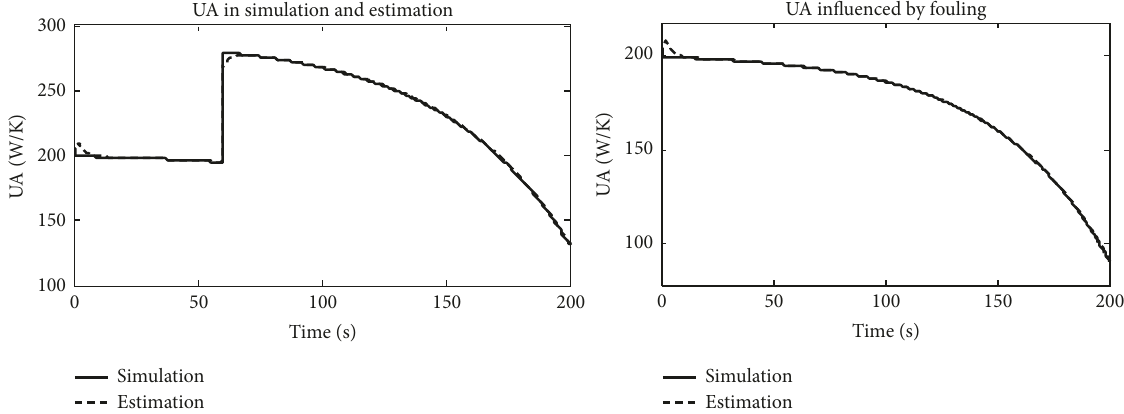
Figure 19: Estimation and simulation under fault